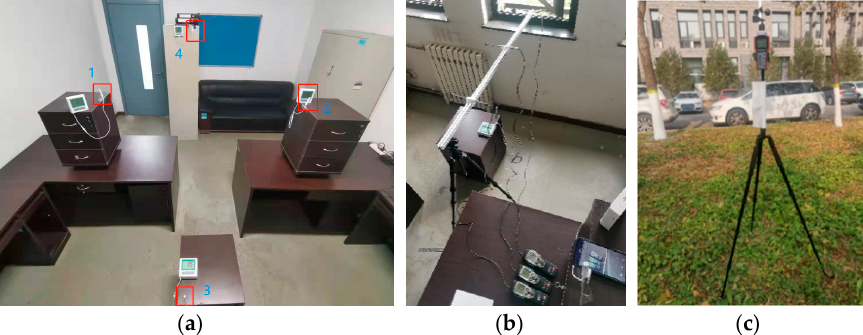
Figure 6. ( a ) Test room with locations of temperature and relative humidity sensors marked, ( b ) locations of anemometers measuring indoor air velocity distribution, and ( c ) the meteorological station placed outside the studied building.